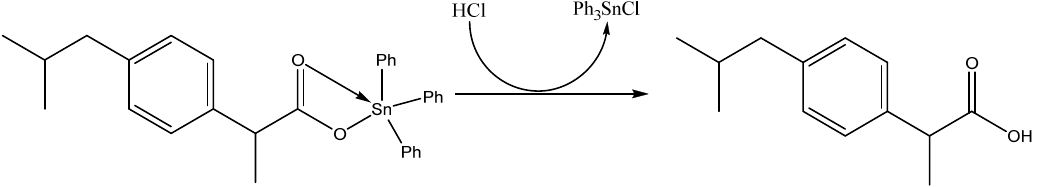
Figure 10. Organotin complexes act as hydrochloride scavengers.